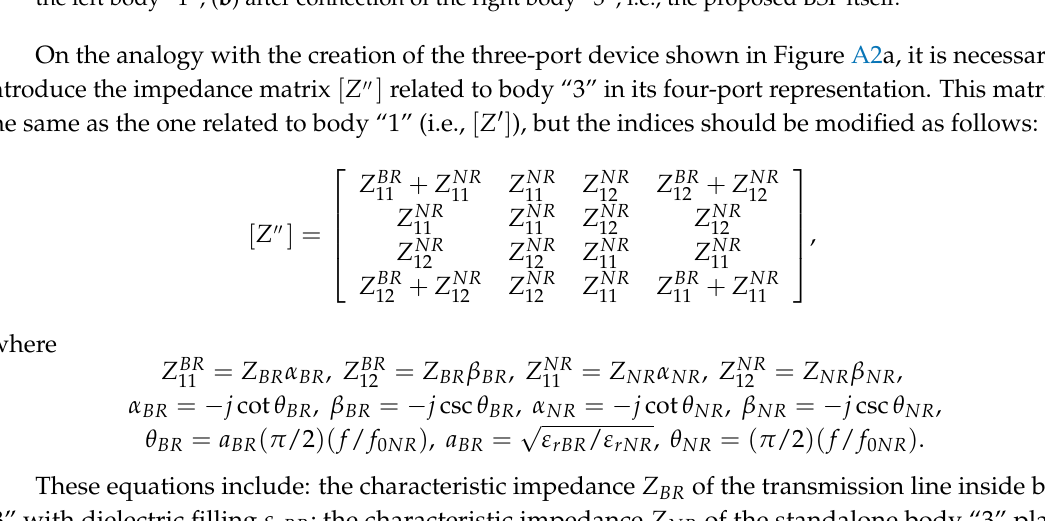
Figure A2. The reduced reentrant multi-ports related to the proposed filter: ( a ) after the connection of the left body “1”, ( b ) after connection of the right body “3”, i.e., the proposed BSF itself.